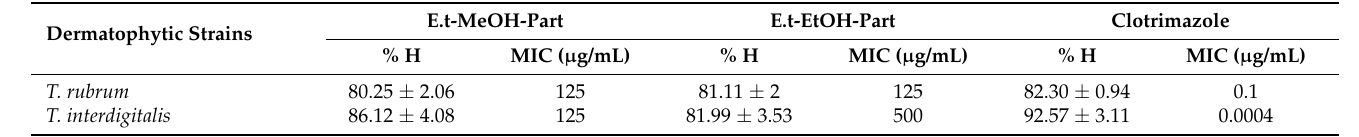
Table 2. Fungal activity of the methanolic and ethanolic partitions of E. tirucalli against clinical isolates of dermatophytes.